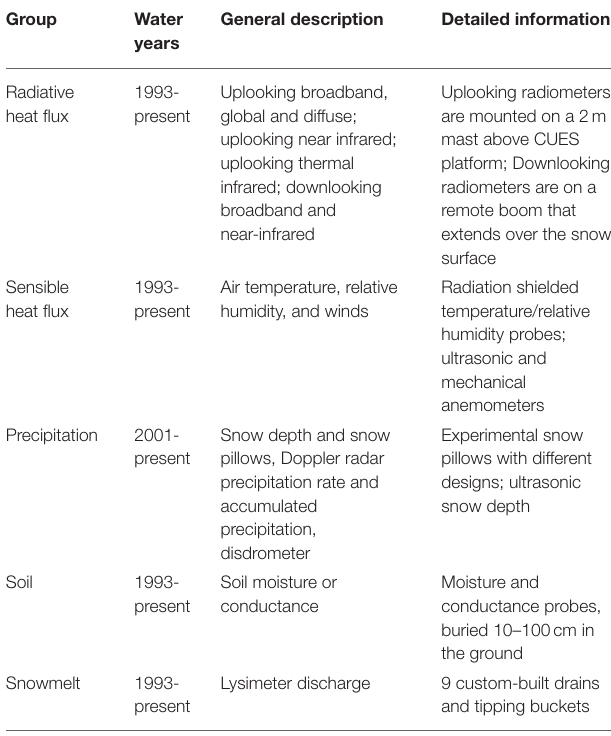
FIGURE 4 | Snowflake images from CUES. Images were recorded by the Multi Angle Snowflake Camera in 2015.